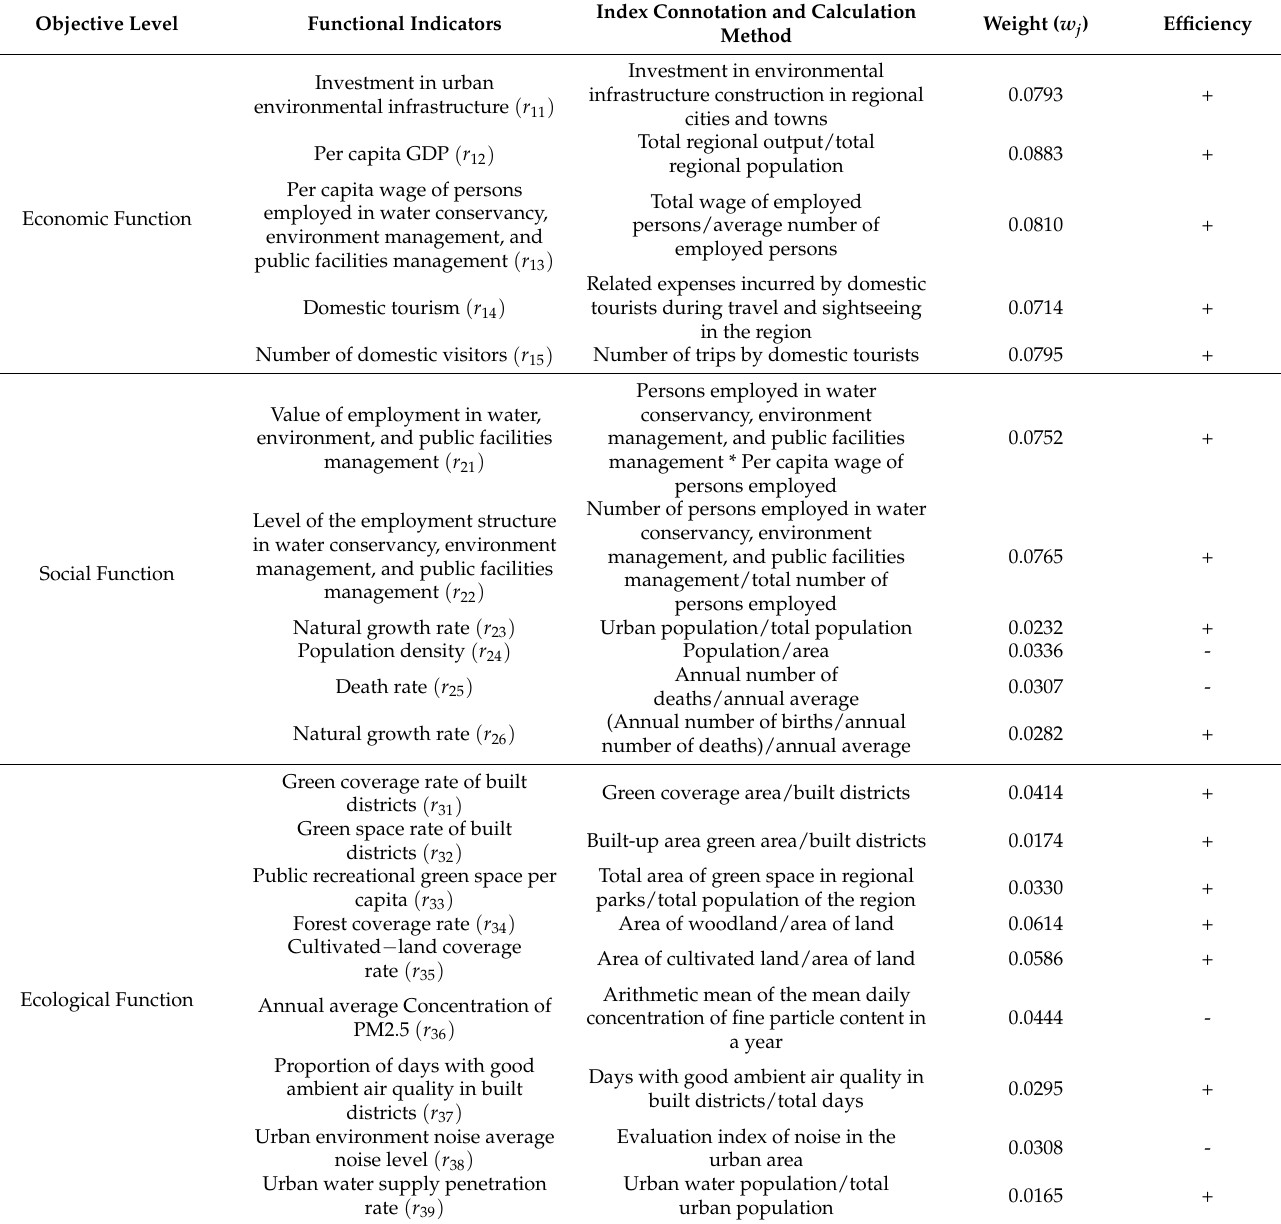
Table 1. Multi-function evaluation index system of green